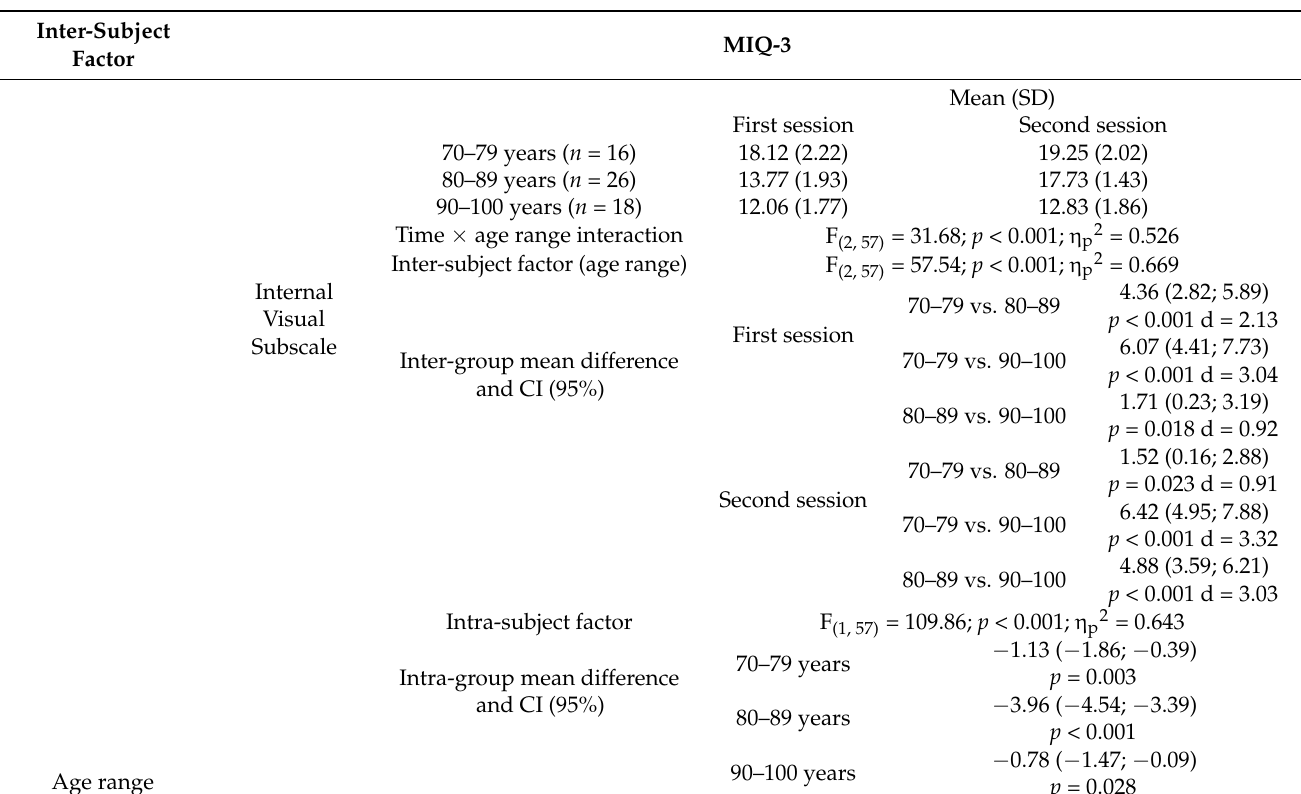
Table 5. The mixed factorial ANOVA results of differences in MI ability as measured by the MIQ-3, by age